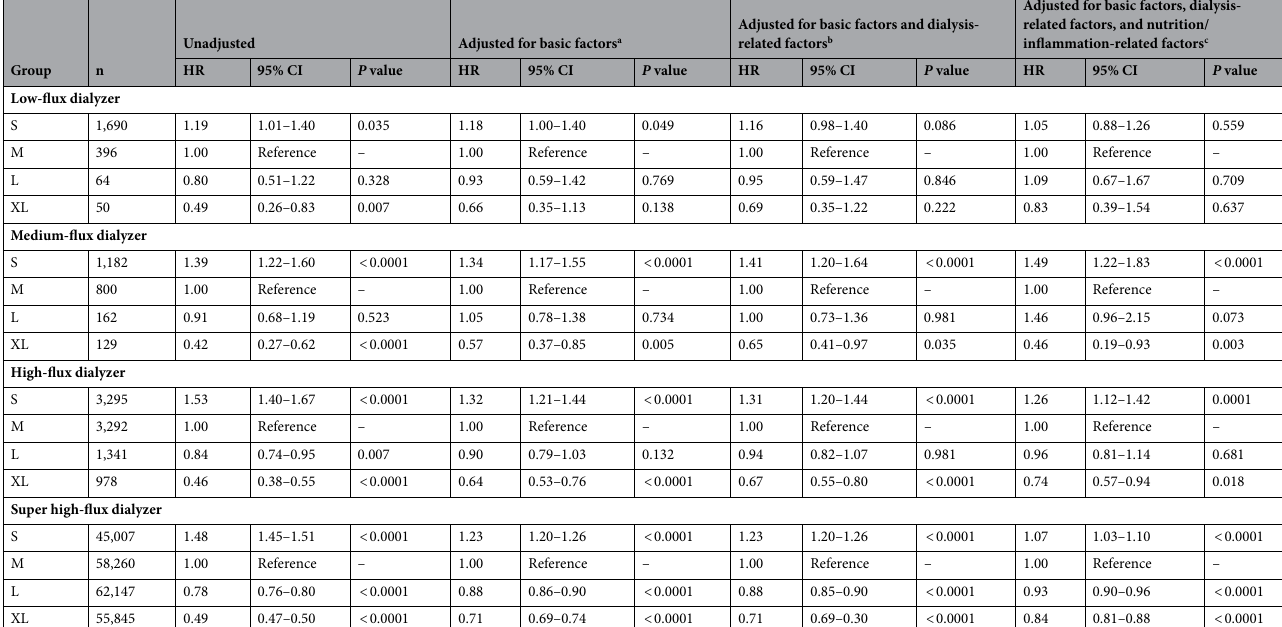
Table 3. Hazard ratios (with 95% confidence intervals) for all-cause mortality according to dialyzer surface area and all-cause mortality classified by dialyzer flux type. S group, small dialyzer surface area, < 1.5 m 2 ; M group, medium dialyzer surface area, 1.5 m 2 ; L group, large dialyzer surface area, 1.6 to < 2.0 m 2 ; XL group, extra-large dialyzer surface area, ≥ 2.0 m 2 . a Adjusted for age, sex, duration of dialysis, presence or absence of diabetes, and cardiovascular disease. b Adjusted for basic factors and dialysis-related factors, including Kt/V, β 2 -microglobulin level, ultrafiltration rate, and dialysis time. c Adjusted for basic factors and dialysis-related factors, C-reactive protein, hemoglobin, normalized protein catabolic rate, serum albumin, body mass index, and simplified creatinine index. CI confidence interval, HR hazard ratio.